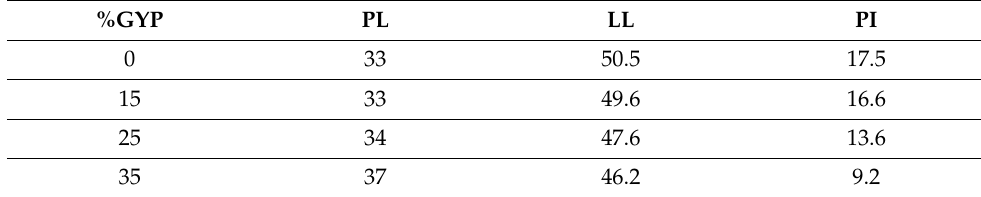
Table 3. Atterberg properties of artificially synthesised gypseous soils.